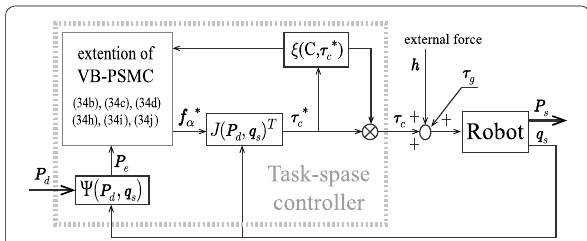
Fig. 3 Block diagram of the whole sysytem (21) including the proposed controller (34)